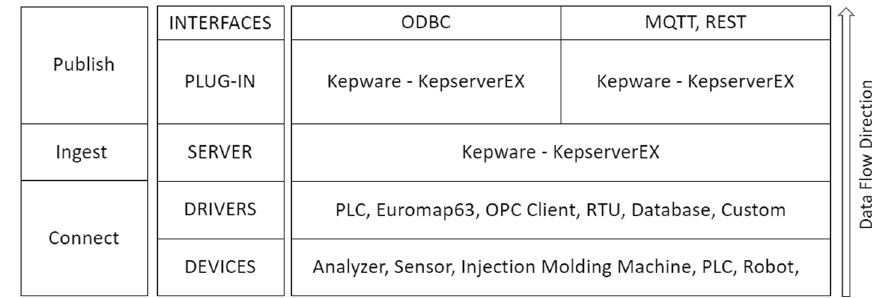
Fig. 4 Digitalization layers of the data and communication protocols of the devices are shown on the diagram. There are 5 types of devices that produce data in different formats and frequencies on the shop floor. This data is digitalized using an OPC server and published via different methods such as MQTT, REST, ODBC to the big data platform